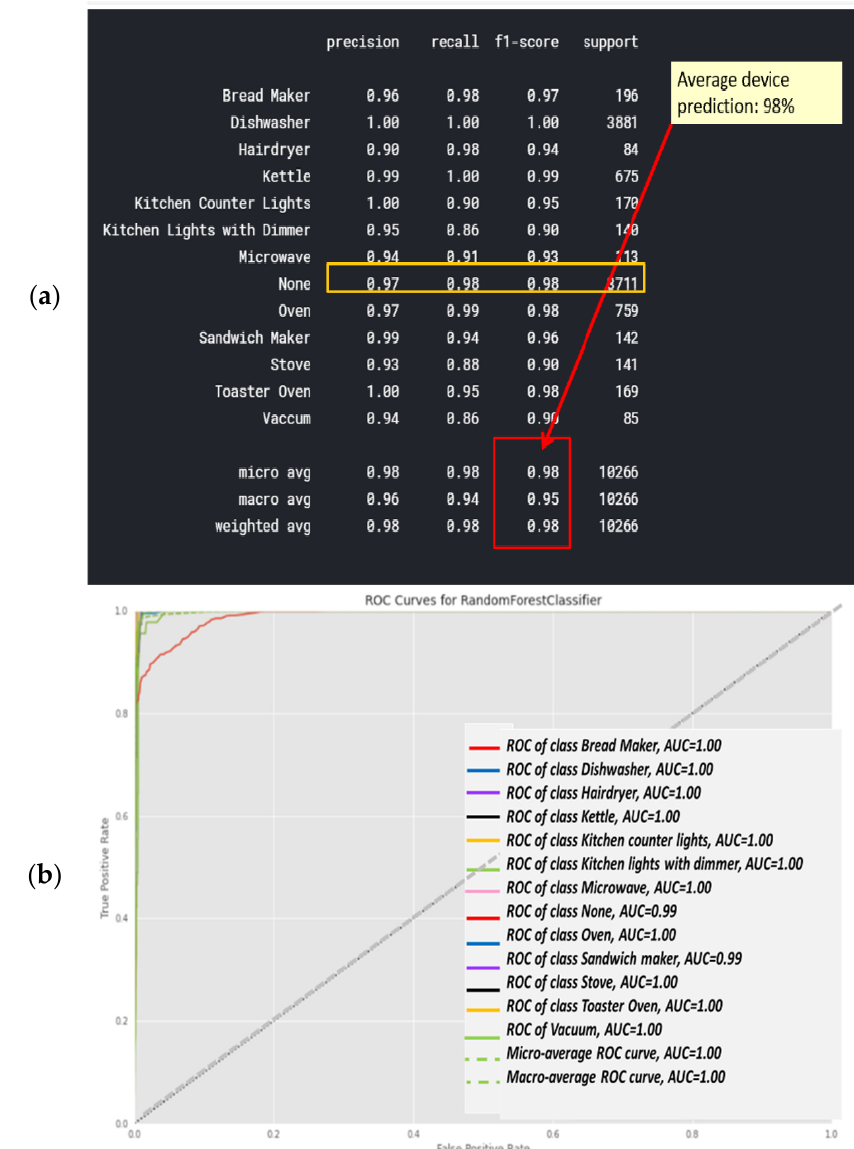
Figure 14. Random forest classifier ( a ) classification report and ( b ) AUC-ROC curves for each of the 13 electrical devices.